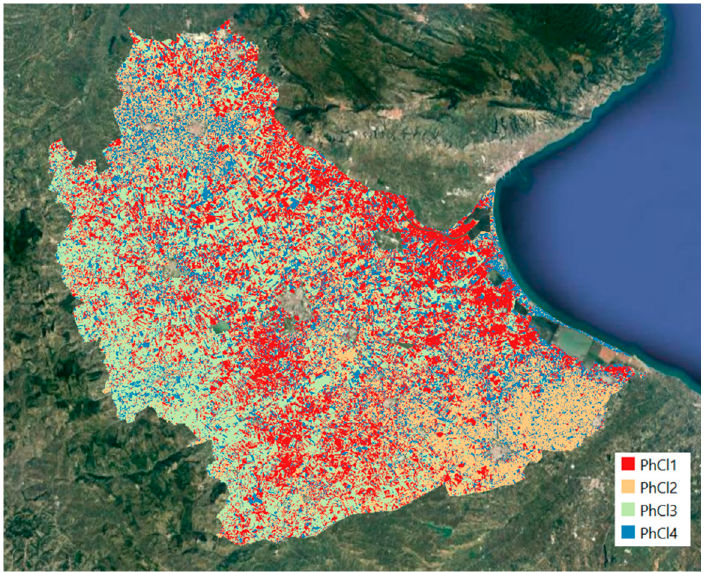
Figure 9. Distribution of the pheno-clusters throughout the study area.